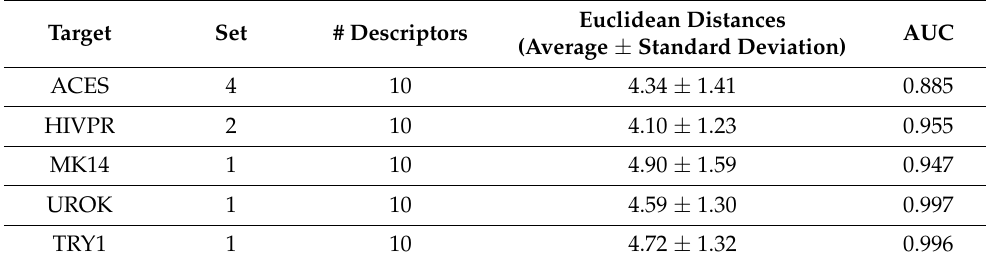
Table 4. Averaged ± SD Euclidean distances between active and decoy compounds for subsets used to derive the best 10-descriptor models for each target. Distances are based on all principle components obtained from